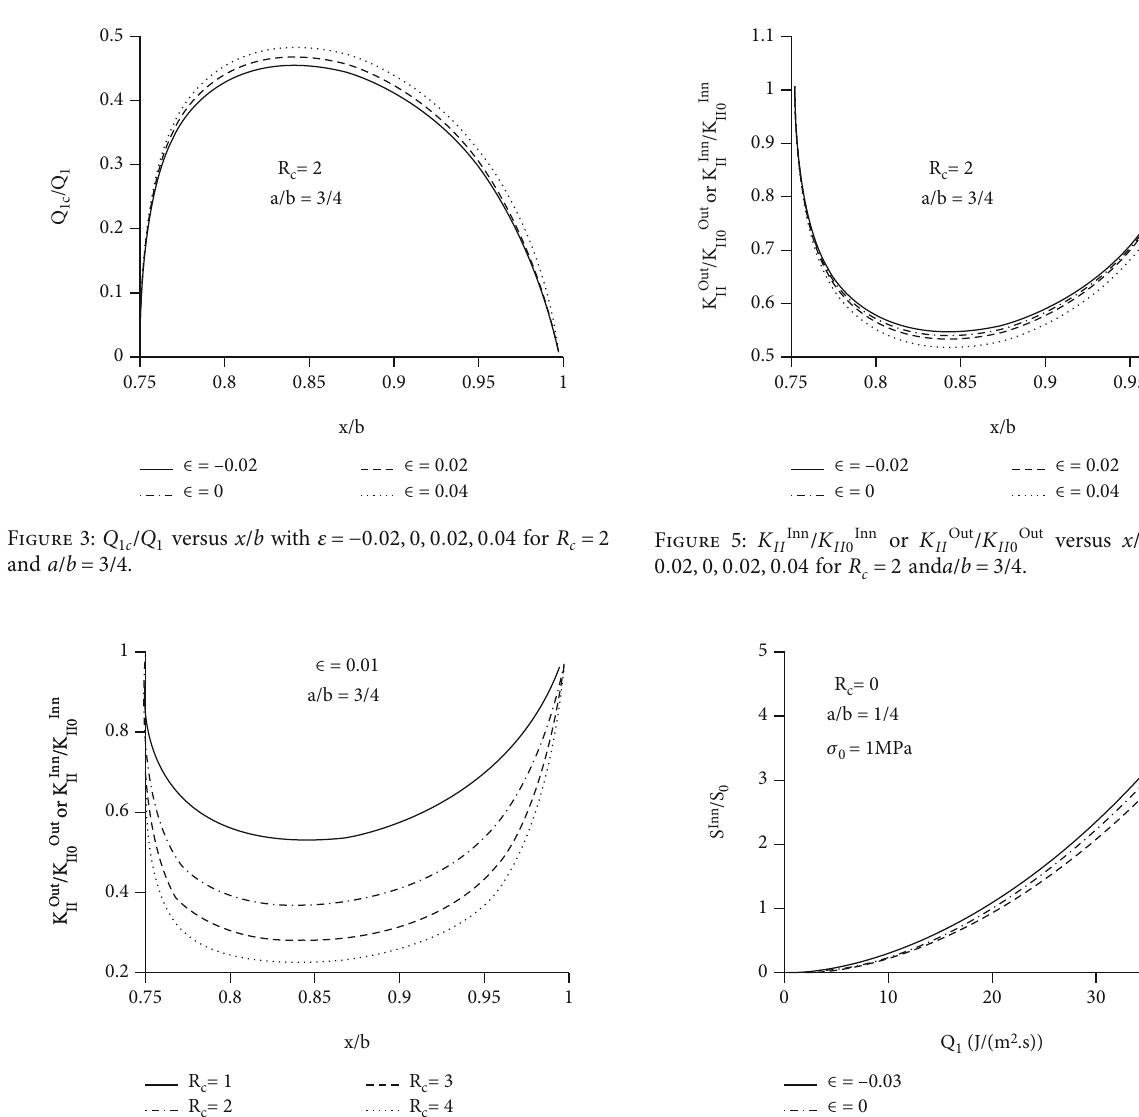
Out / K 0Out versus x / b with R II II